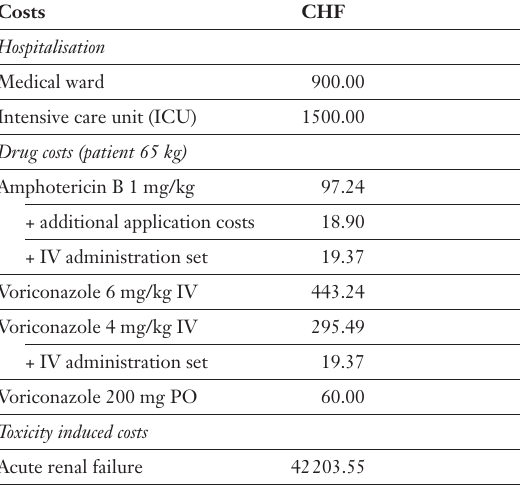
on the model results. These calculations were performed to test the impact of variables, which may influence the cost-effectiveness outcome. Theses variables included: pa- tient weight, duration of voriconazole IV treatment after switching from amphotericin B (second line), cost esti- mates for daily costs of hospital resources and per day in ICU, cost estimates per case of acute renal failure and dif- ferent incidence rates regarding acute renal failure.